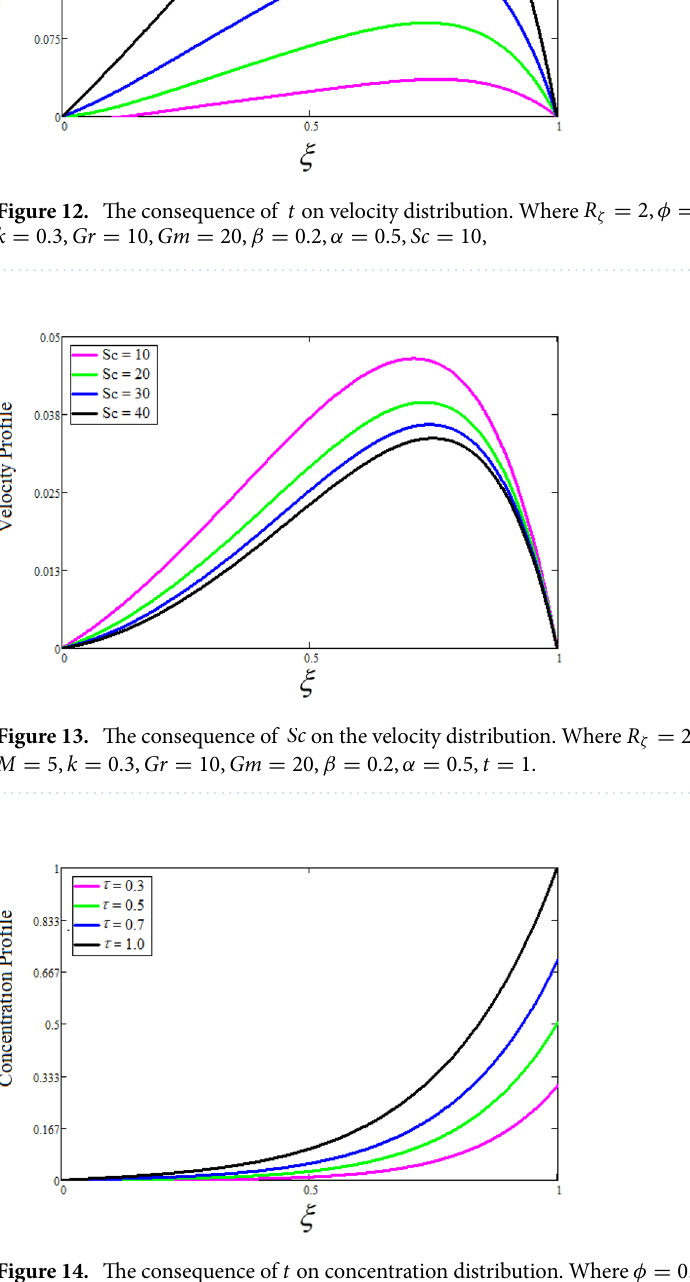
Figure 14. The consequence of t on concentration distribution. Where φ = 0.01, α = 0.5, Sc =